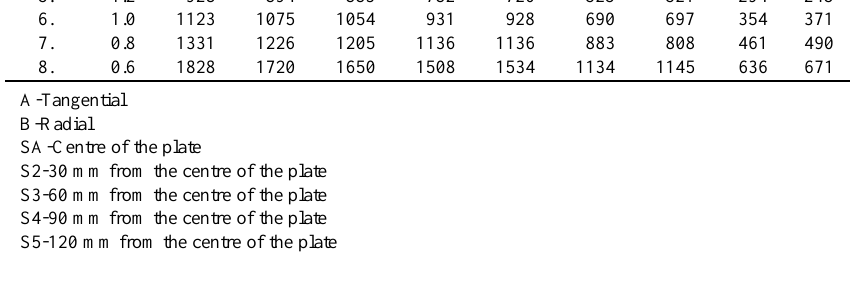
Table 4 Summary of underwater explosion parameters for elastic strain experiments on the circular plate; Charge quantity = 0.01 kg